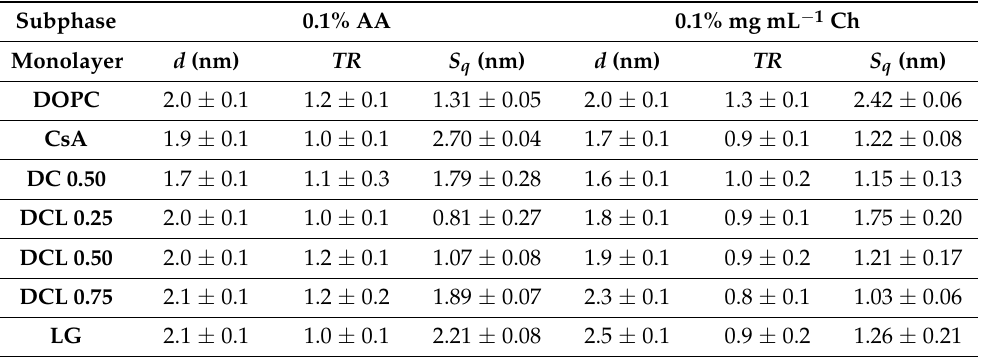
Table 1. Thickness ( d ) and transfer ratio ( TR ) values for the indicated monolayers obtained at the air/AA and air/Ch interfaces as well as the S q roughness parameter gained by means of the AFM for the modified PET